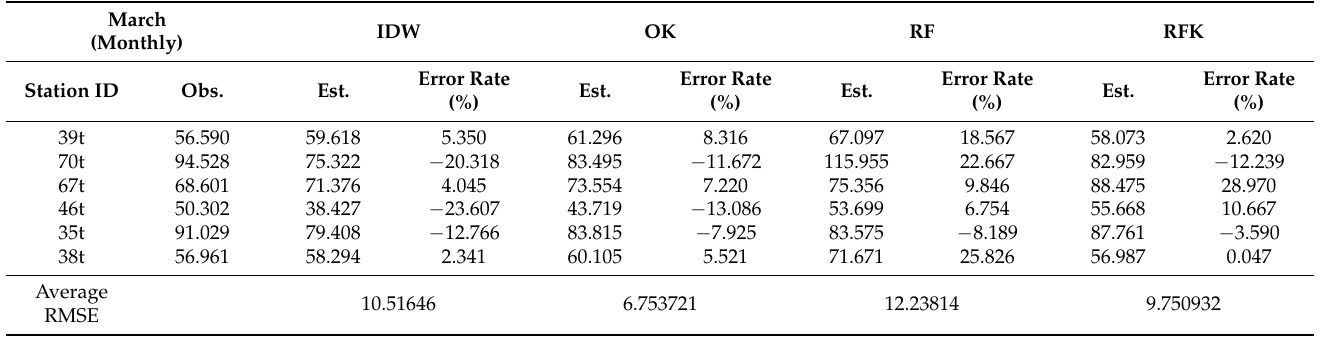
Figure 11. Location of stations used in station-based comparison with the dataset ( a ) in March and ( b ) in February. Table 3. Test station-based comparison between observations and estimates from interpolation models with observed concentration over 50 μ g/m 3 from a monthly dataset in March.